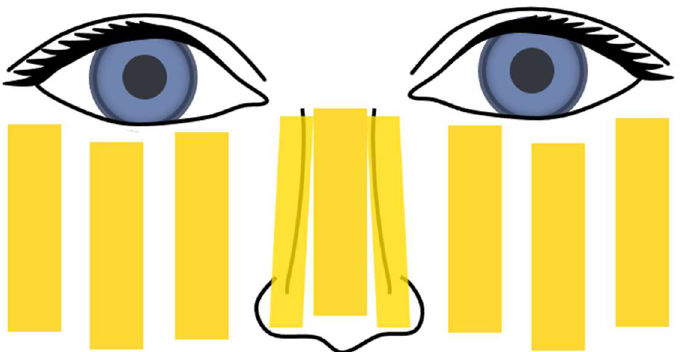
Figure 1. IPL treatment sites (marked in yellow). Approximately 9 symmetrical pulses were applied on the nose and cheek.